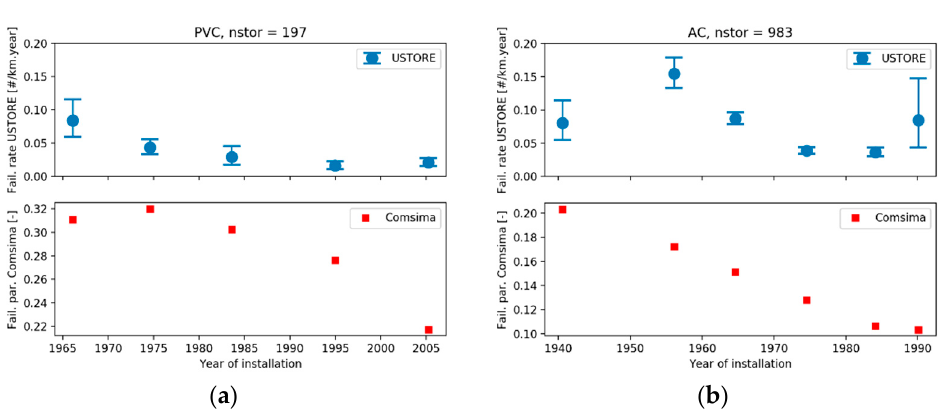
Figure 4. Comparison of Comsima results with failure data as a function of pipe age. Failure rate from failure registrations are shown in the upper panels and the failure parameter calculated by Comsima in the lower panels for PVC ( a ) and AC ( b